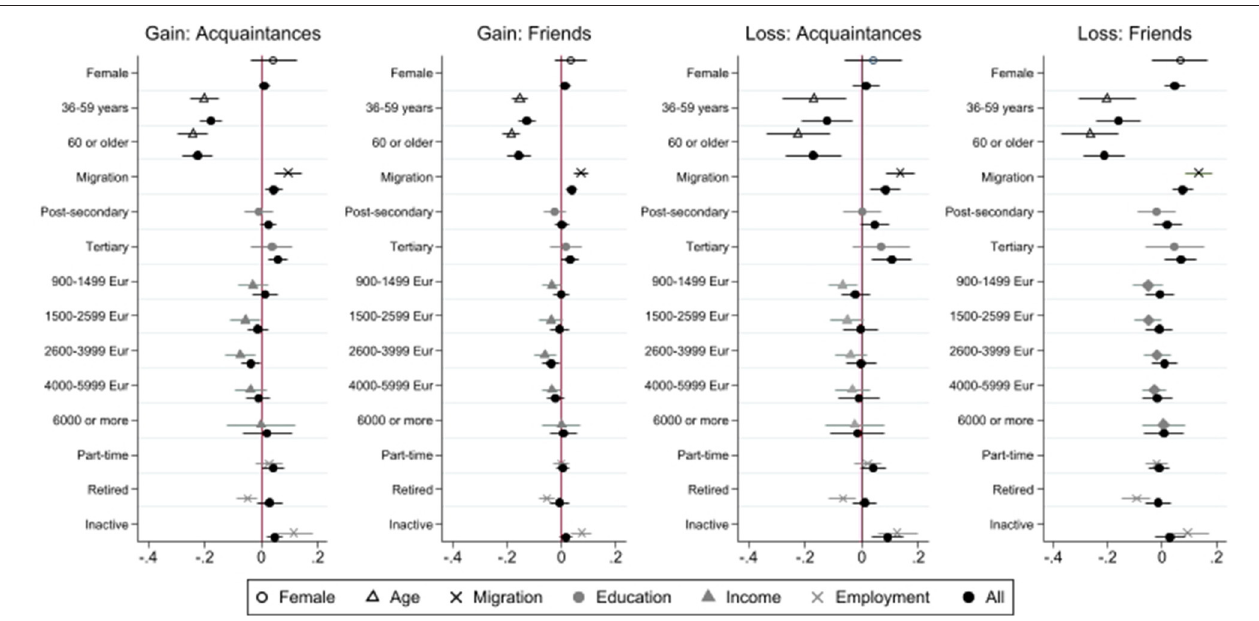
FIGURE 2 | Socio-Demographic and Socio-Economic Determinants of Network Change. Source: Survey “Living in exceptional circumstances,” Wave 3 (spring 2021). n = 3,713 respondents, 18–98 years. Multivariate logistic regression models, weighted, Average Marginal Effects (difference in likelihood in percent). Bivariate coefficients for each socio-demographic resp. socio-economic variable (coefficients: “Female”, “Age”, “Migration”, “Education”, “Income”, and “Employment”) and coefficients from simultaneous model estimation, including controls for urbanity and East Germany (coefficient “All”). Reference categories: Man, Age 16–34, No Migration Background, Compulsory Education, Income < 900 Euros/month, Full-time employment. For full set of coefficients, see in Supplementary Table 2 . For comparison with full model (including additional controls), see Supplementary Table 2 (last